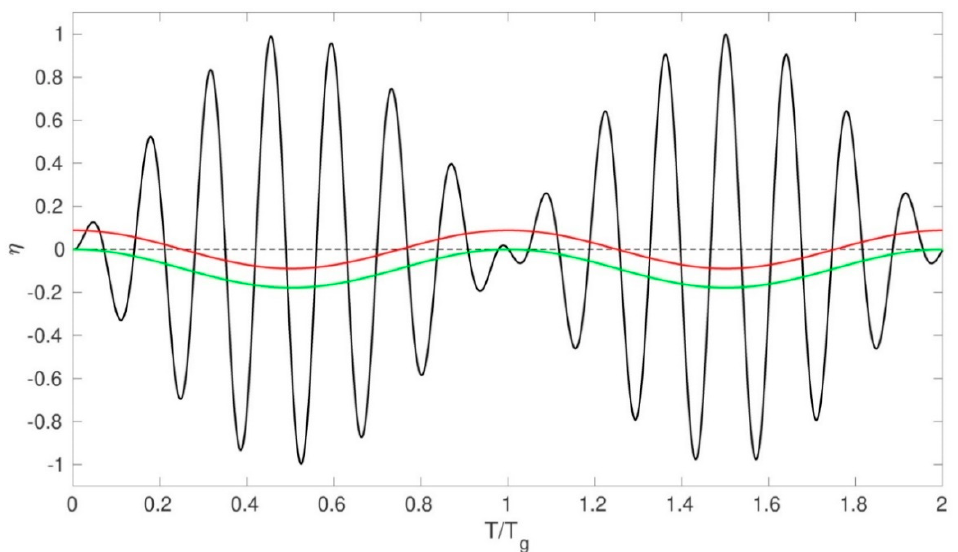
Figure 1. Two different graphical interpretations of the bound wave forced by a short wave groups (black line) by Longuet-Higgins and Stewart [1] with positive and negative elevations (red line), and Mei [2] with purely negative elevation (green line).